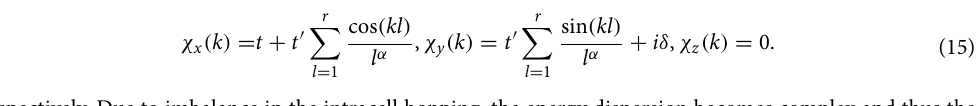
respectively. Due to imbalance in the intracell hopping, the energy dispersion becomes complex and thus the non-Hermiticity is introduced into the model. For the current model, energy dispersion is given by